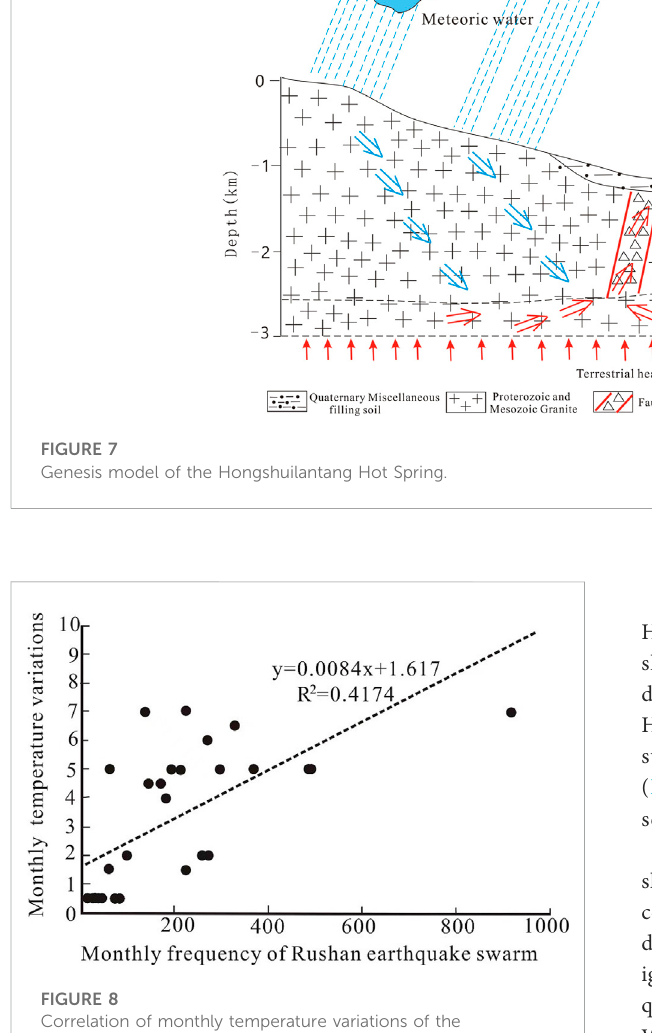
FIGURE 8 Correlation of monthly temperature variations of the Hongshuilantang Hot Spring and monthly frequencies of the Rushan earthquake